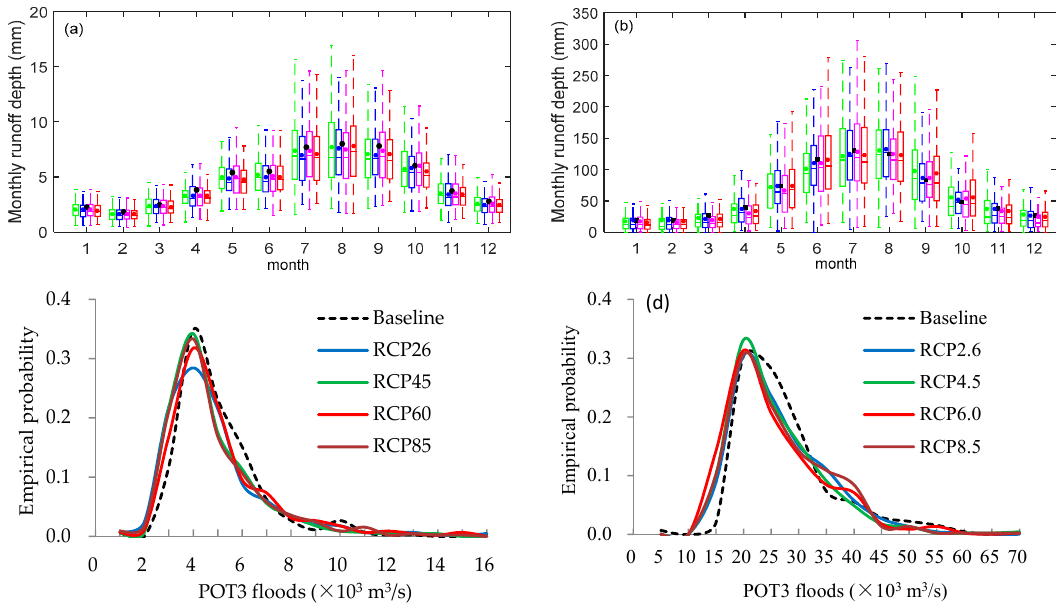
Figure 6. Simulated monthly runoff for 2021–2050 under four RCPs and the baseline in ( a ) the Yellow River Basin and ( b ) the Xijiang River Basin. Green, blue, pink, and red boxes represent RCP2.6, RCP4.5, RCP6.0, and RCP8.5, respectively. Black and colored dots represent baseline and period averages of multi-GCM means under the RCPs. Empirical probability of POT3 floods in ( c ) the Yellow River Basin and ( d ) the Xijiang River Basin for baseline and 2021–2050 under RCP2.6, RCP4.5, RCP6.0, and RCP8.5.